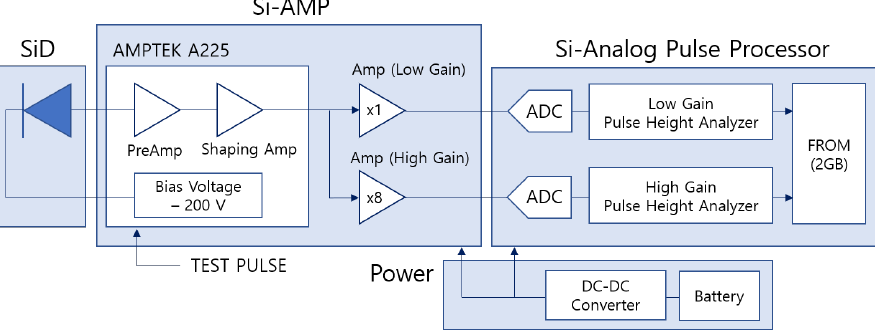
Figure 4. Schematic of the Self-made Electronics for the Particle Dosimeter and Spectrometer